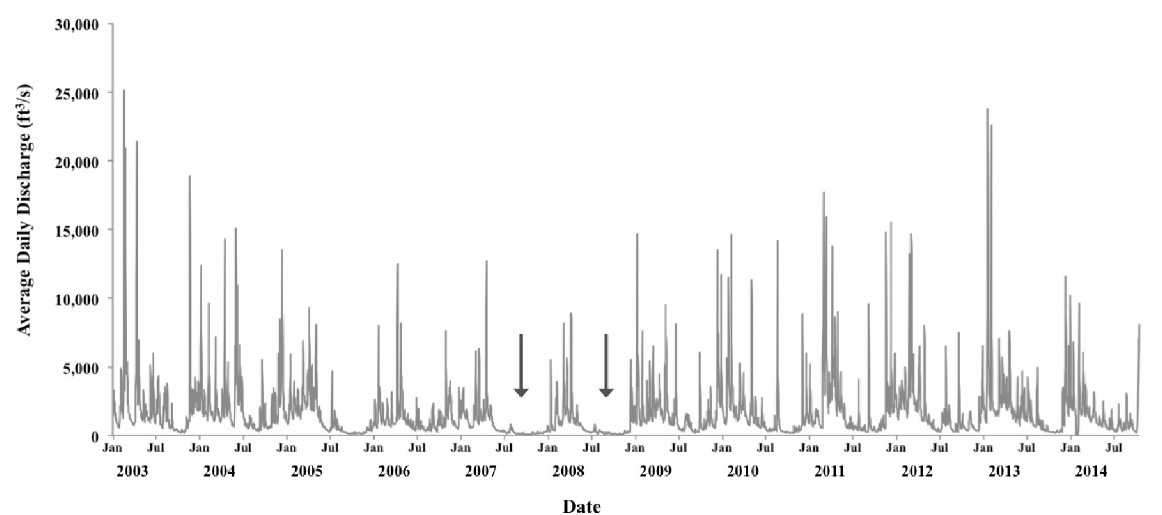
Fig 11. Stream discharge (ft 3 /sec) recorded in the mainstem Clinch River above Tazewell, Claiborne County, Tennessee (data from U.S. Geological Survey, gauge 03528000) from June 2003 to December 2014. Arrows indicate periods of low discharge conditions in the river from early spring to early